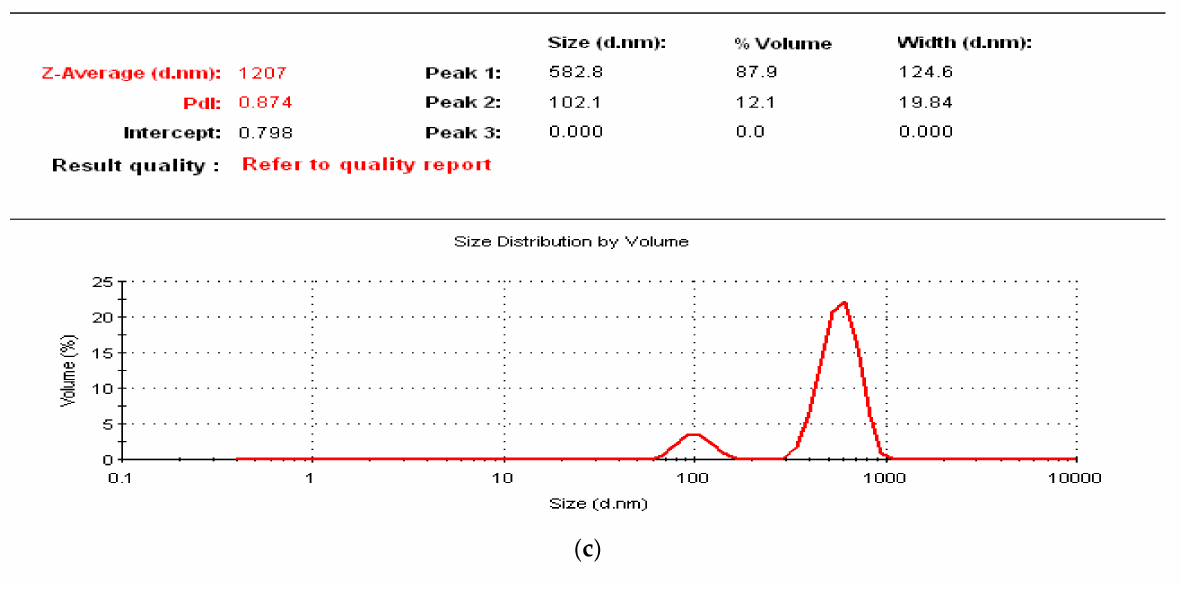
Figure 9. %Volume/size distribution of sonicated ( a ) GNFC/NaClO, ( b ) GNFC/NaOH, and ( c ) GNFC/H 2 SO 4 using the particle size analysis (PSA).